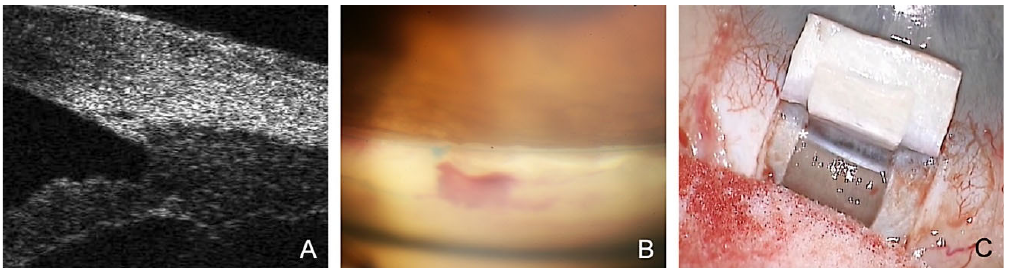
Figure 1. Rationale and mechanisms of action of canaloplasty. ( A ) Viscodilatation of the SC with microcatheter shown in UBM. ( B ) Prolene tension sutures are visible postoperatively on gonioscopy, resulting in permanent stretching of the TMW. ( C ) Controlled percolation of aqueous humor through the TDW.